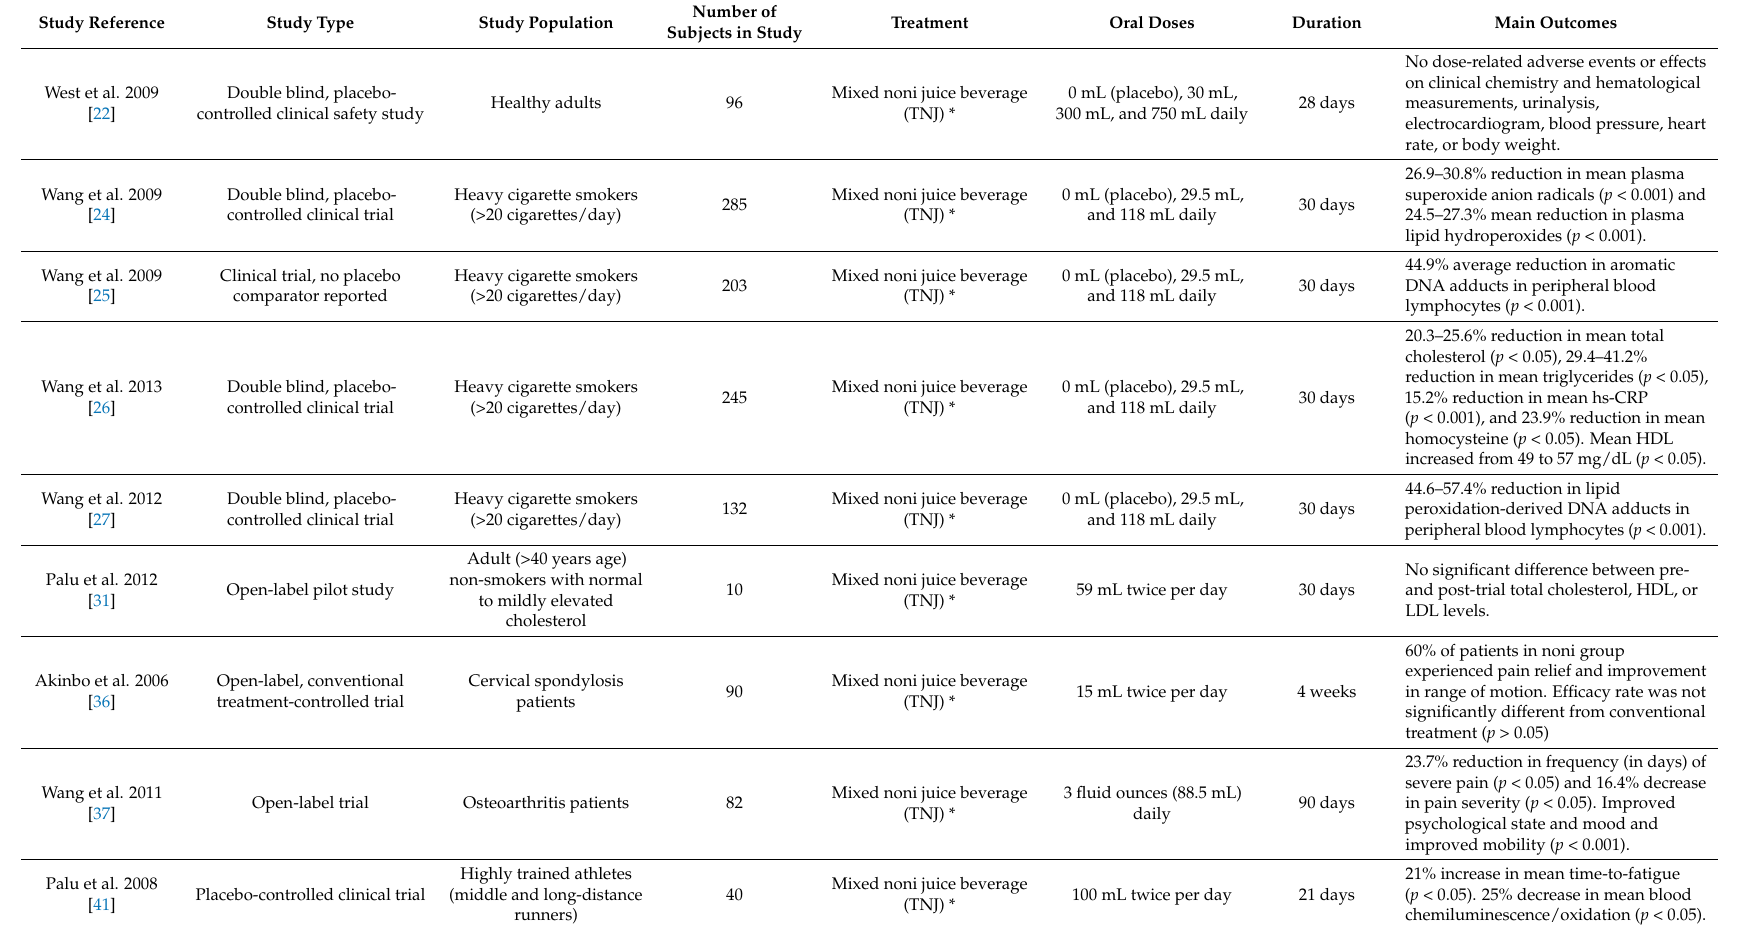
Table 1. Summary of human intervention studies of noni juice